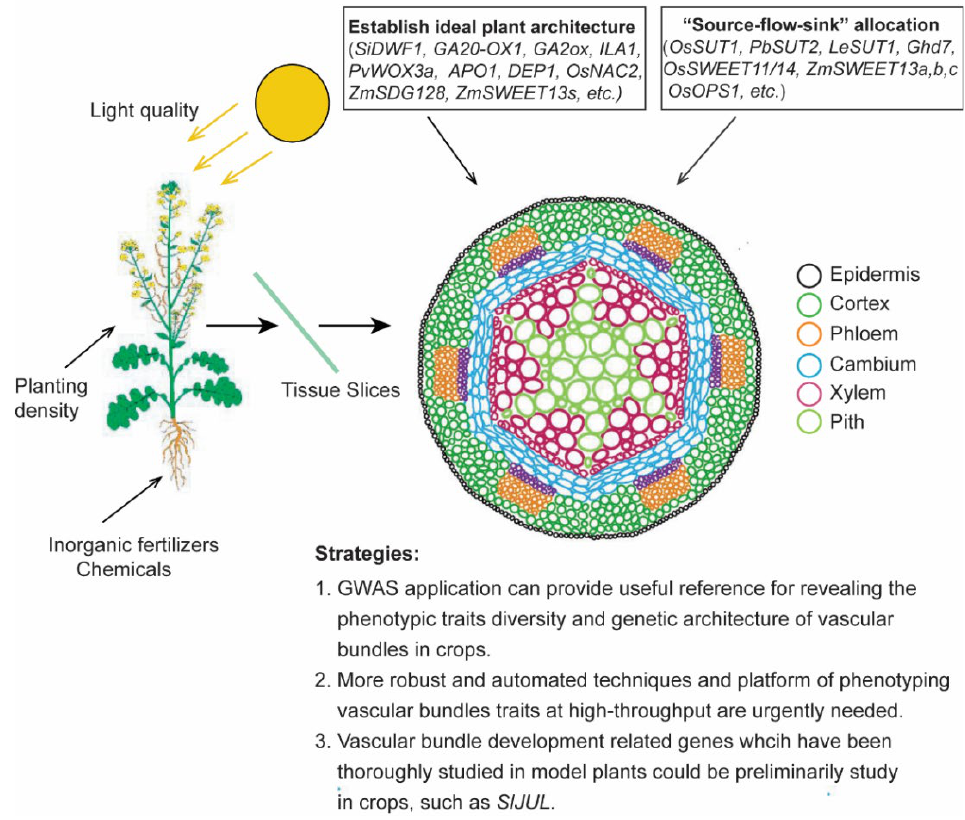
Figure 2. A summary of biomolecular strategies for vascular bundle development to improve crop yield. Environmental factors influence crop vascular system development. And many studies have been carried out on the genes related to vascular bundle systems in crops, which mostly help to establish ideal plant architecture and influence “source-flow-sink” allocation. Several strategies have been proposed here to help explore vascular bundle development.